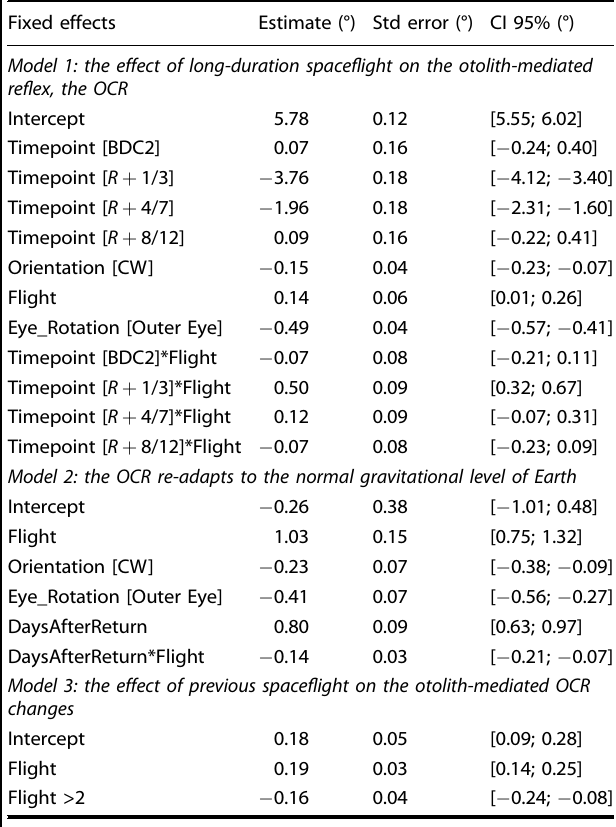
Table 3. Overview of the speci fi cations or estimates of the different linear mixed models (LMM). Fixed